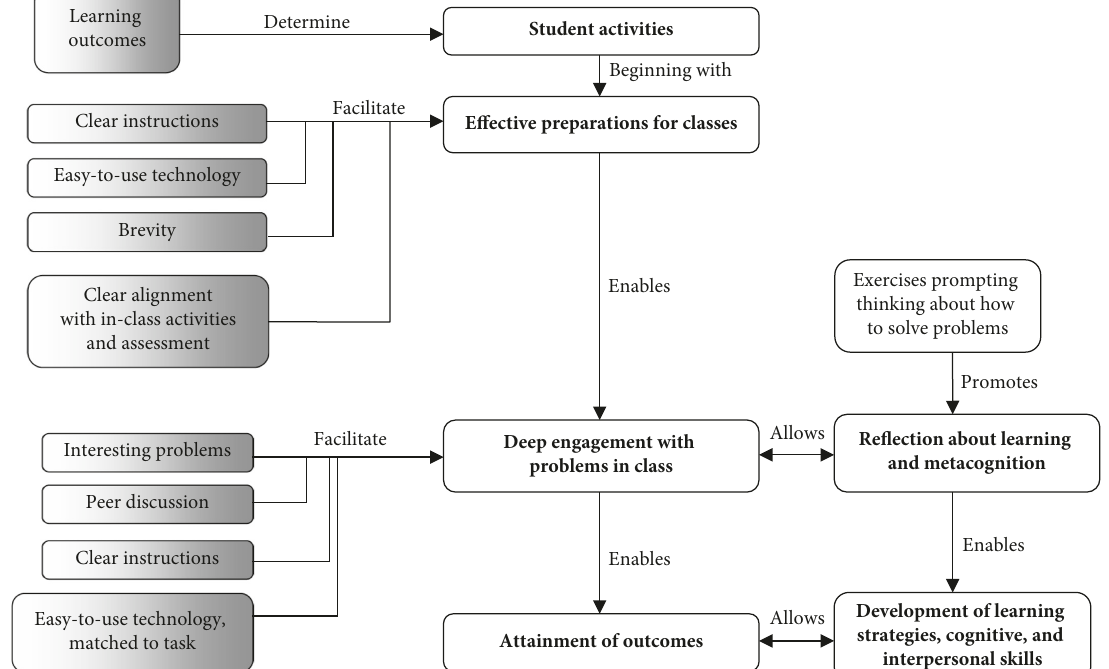
Figure 12: A concept map of flipped learning and classroom (adapted from [141]). Note. Student behaviour is shown in bold; instructor behaviour is shown in